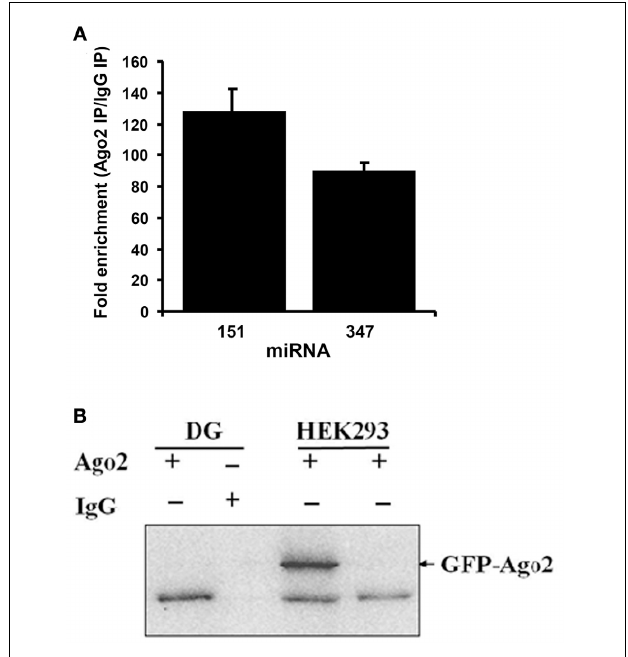
FIGURE 1 | Validation of Argonaute 2 immunoprecipitation. (A) Specific Ago2-immunoprecipitation of brain-enriched miRNAs. TaqMan qPCR for brain-enriched miR-347 and miR-151 was performed in Ago2 immunoprecipitated (IP) or non-immune mouse IgG immunoprecipitated samples from dentate gyrus. Values are means ( + s.e.m.; n = 3) expressed as fold enrichment in the Ago2 IP relative to IgG IP. (B) Ago2 immunoblots following immunoprecipitation of dentate gyrus (DG) samples with Ago2 antibody or non-immune mouse IgG. A band at ∼ 97kDa corresponding to Ago2 was detected in Ago2, but not IgG, IP. As a positive control, HEK293 cells were transfected with GFP-Ago2. Endogenous Ago2 protein (lower band) and GFP-Ago2 fusion protein (arrow; band at ∼ 127kDa) were detected in transfected